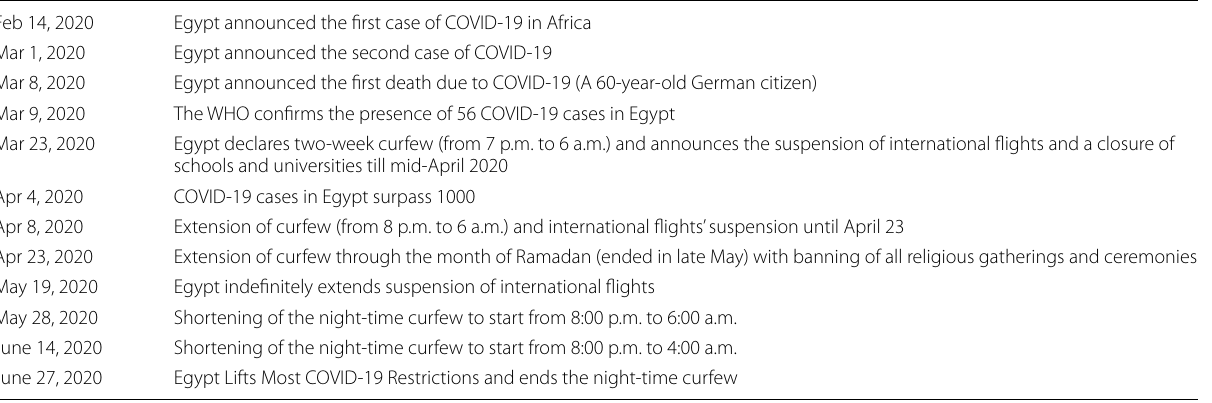
Table 2 The serial responses of the Egyptian government to the COVID